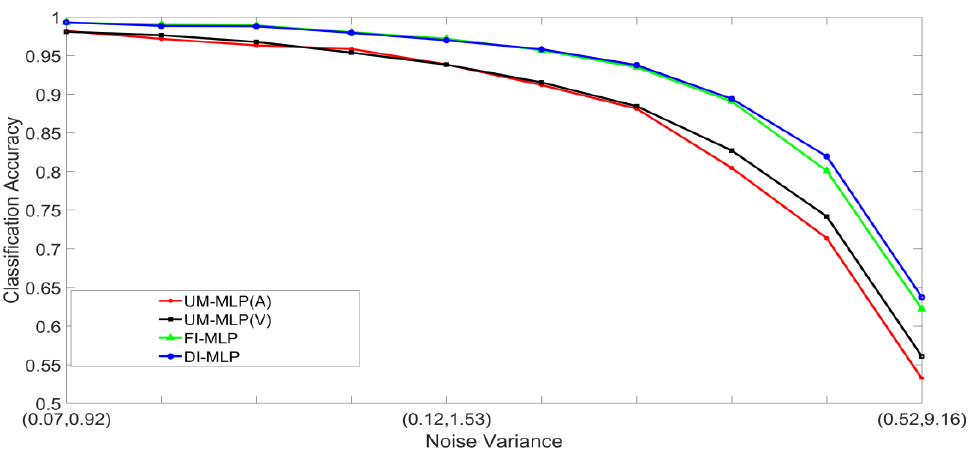
Figure 10. Classification accuracy, as a function of noise, and 𝛼 = 0.8 in both stimuli, for the MLP-based classification systems.